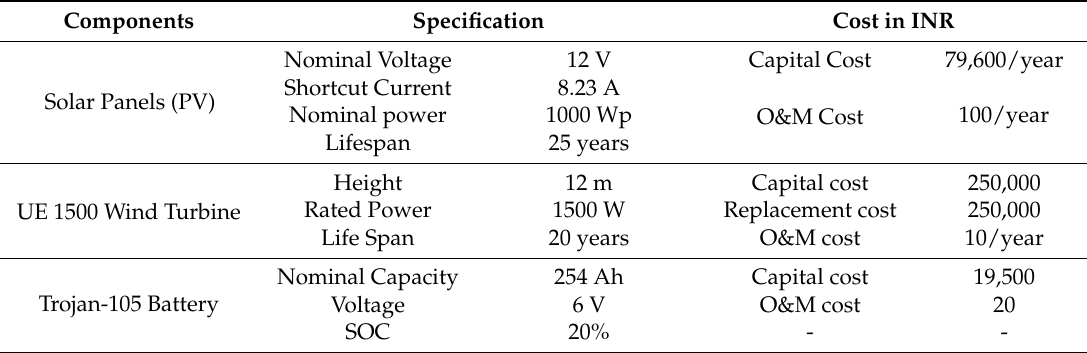
Table 2. The HRES components, component specifications, and market